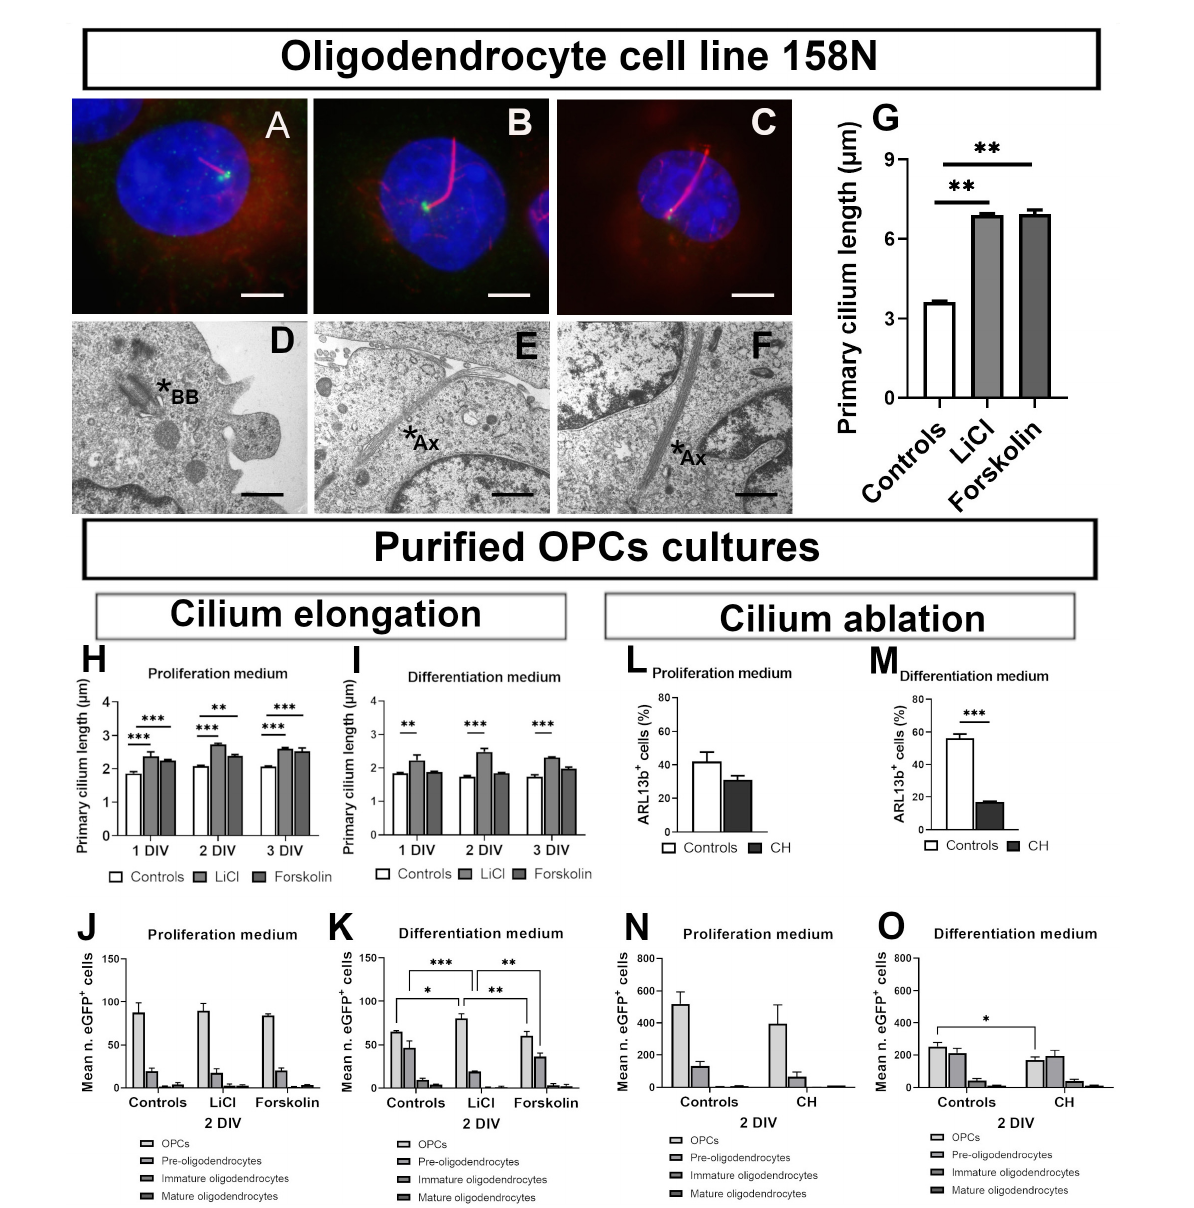
FIGURE2 Primary cilium plasticity in oligodendroglial cell line 158N and purified OPCs cultures. (A–F) Cilium in 158 cell line. (A–C) Representative photomicrographs of cilia in controls (A) , LiCl (B) and forskolin (C) treated 158N cells. Primary cilium was stained by acetylated tubulin (Ac Tub) and basal body by y-tubulin. Scale bar: 5 µ m. (D–F) Representative ultrastructural PC morphology. Mother centriole beginning to extend a short axoneme associated to its membrane vesicle in the cytoplasm (D) and long axonemes in LiCl treated cells (E,F) ; scale bar: 300 nm. Stars shown basal body (BB) in (D) and ciliary axoneme (Ax) in (E,F) . (G) Both Lithium and forskolin lengthened cilia in 158N cells (One-way ANOVA followed by Bonferroni post-hoc test; ** p < 0.01; n = 3). (H–O) Cilium in primary oligodendroglial cell cultures. (H–K) Effect of lithium chloride and forskolin. In proliferation medium, both lithium and forskolin lengthened cilia (H) . In differentiation medium only lithium was able to elongate primary cilium (I) at the tree times studied (one-way ANOVA followed by Bonferroni post-hoc test; ** p < 0.01, *** p < 0.001. n = 3). (J,K) The distribution of eGFP + cells at 2 DIV of culture was not modified in proliferation medium. (J) In differentiation medium, lithium maintains cells in an immature state while forskolin had no effect. (K) Statistical significance was determined by two-way ANOVA and Bonferroni post-hoc test was employed for multiple comparisons. Data are presented as mean ± error of the mean (SEM) and asterisks indicate: * p < 0.05, ** p < 0.01, *** p < 0.001. (L–O) Effect of chloral hydrate (CH). CH did not ablate PDGFR-a + cells PC in proliferation medium (L) but only in differentiation medium (M) (student’s t -test; *** p < 0.001). (N,O) Effect of CH on eGFP + cells distribution in proliferation and differentiation media at 2 DIV of culture. CH did not modify cells distribution in proliferation medium (N) ; in differentiation medium (O) , CH treatment reduced the number of cells in the less differentiated stages. Statistical significance was determined by Two-way ANOVA and Bonferroni post-hoc test was employed for multiple comparisons. Data are presented as mean ± error of the mean (SEM) and asterisks indicate: * p <